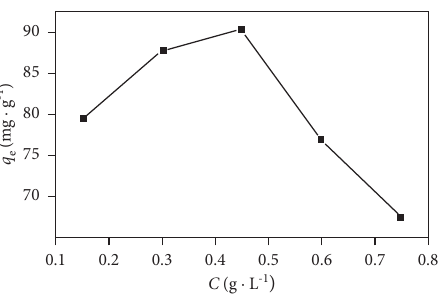
Figure 3: The effect of the amounts of Cu (I)-MOF for Cr (VI) adsorption in aqueous solution.